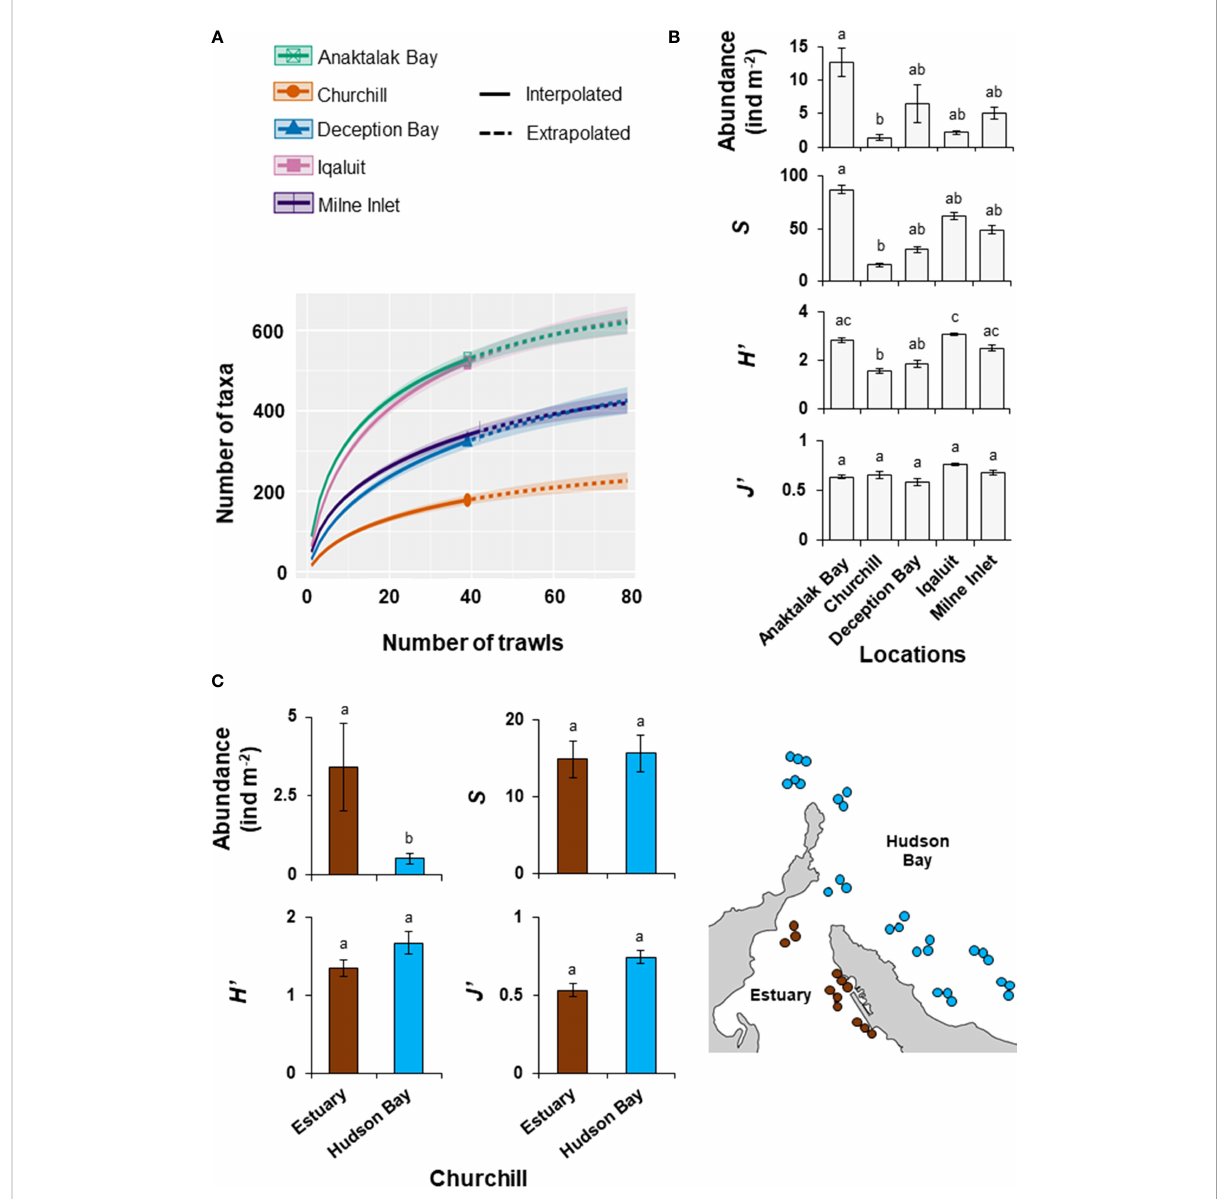
FIGURE 2 Diversity metrics in shallow coastal areas of the Canadian Arctic. (A) Sample-size based rarefaction curves with 95% con fi dence intervals for each Arctic locations. Comparison of abundance (ind m -2 ), taxonomic richness ( S , number of taxa), Shannon-Wiener diversity ( H ’ ), and Pielou ’ s evenness ( J ’ ) among (B) Arctic ports and (C) between Churchill Estuary and Hudson Bay. Data is shown as mean ± se. Means with different letters are signi fi cantly different. See Table 2 for full statistics and Figure 1 for geographic